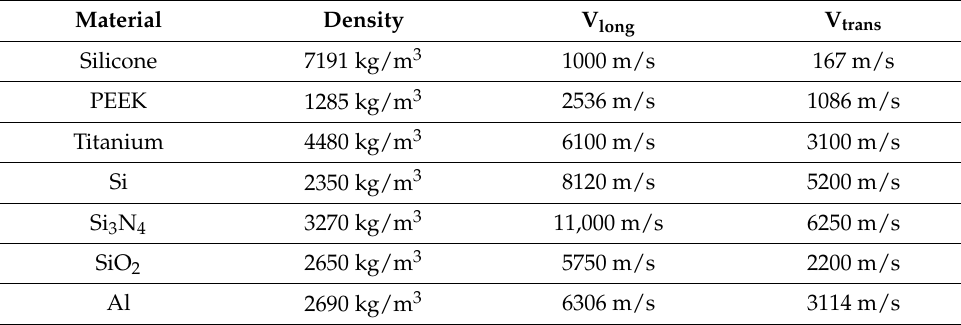
Figure 1. Capacitive micromachined ultrasonic transducer (CMUT) cell model simulated in OnScale. Table 1. Material parameters used in the